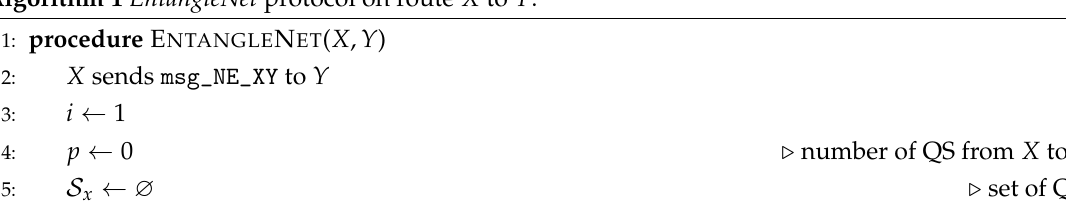
Algorithm 1 EntangleNet protocol on route X to Y